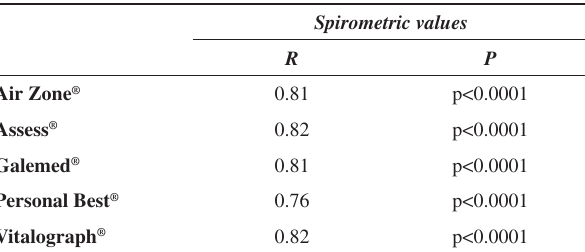
Table 2 - Spearman’s correlation coefficients calculated for the spiromet- ric values and those observed with the five meters. Spirometric values